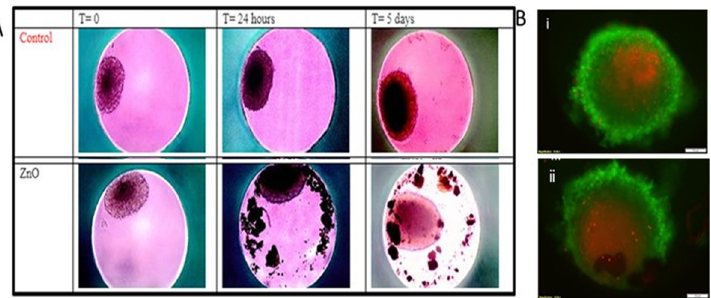
Fig 4. A. Anticancer activity of ZnO NP in HeLa cell spheroids at 0 h, 24 h and day. B. i. Untreated spheroids ii. Spheroids treated with ZnO